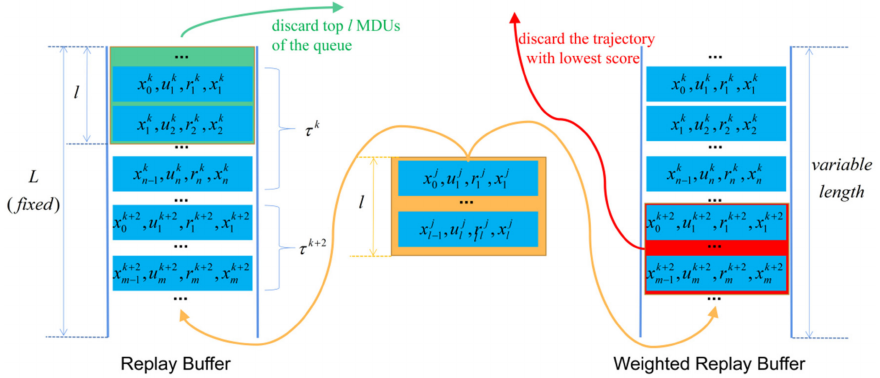
Figure 2. Comparison of updating processes between traditional replay buffer ( left ) and weighted replay buffer ( right ). The yellow line represents the new experiences that will be stored. The green line and the red line represent the experiences that need to be discarded in the traditional replay buffer and the weighted replay buffer,